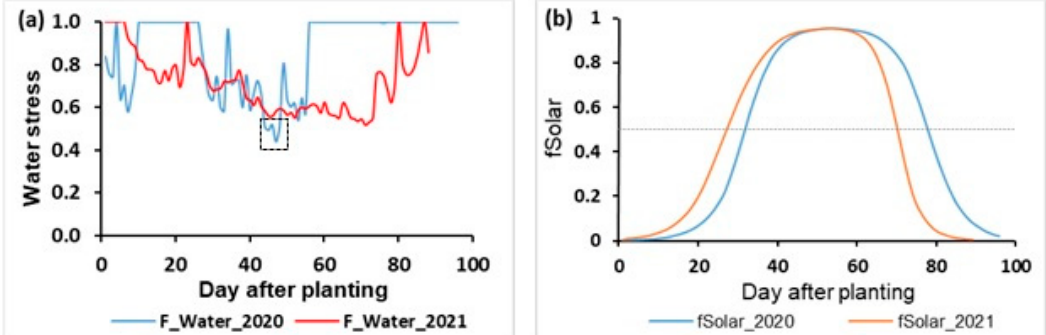
Figure 5. Water stress index ( a ) and simulated fraction of intercepted photosynthesis active radiation—fSolar ( b ) for Summer–Autumn 2020 and Spring–Winter 2021.